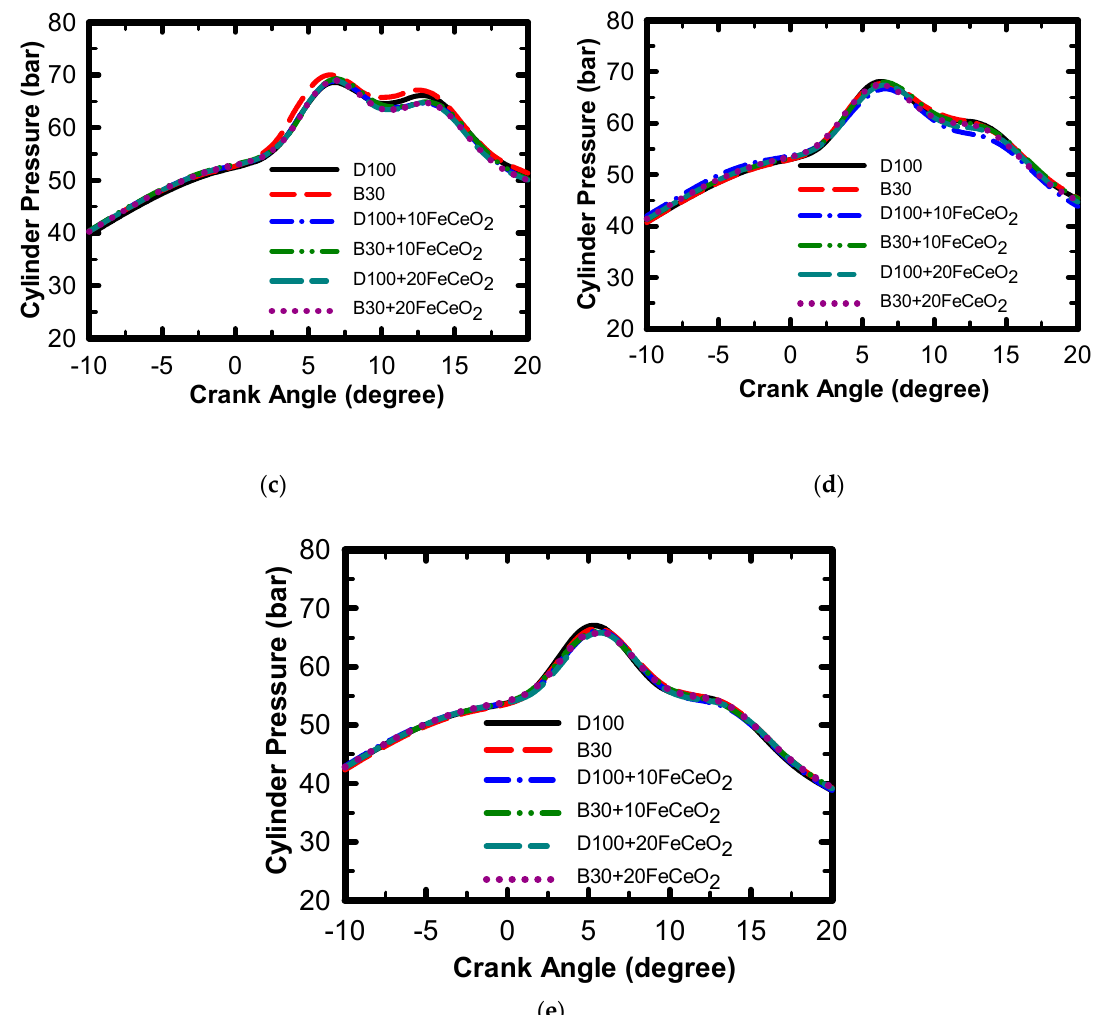
Figure 5. The average cylinder pressure profile at different engine loads and engine speed of 2000